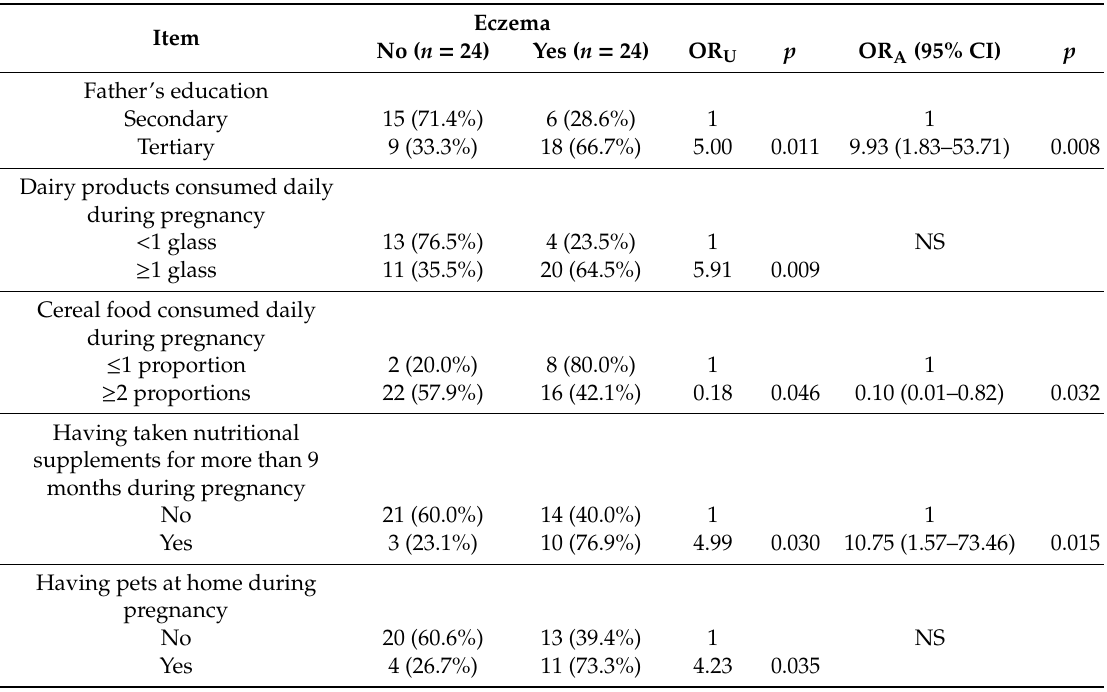
Table 6. Factors associated with the occurrence of